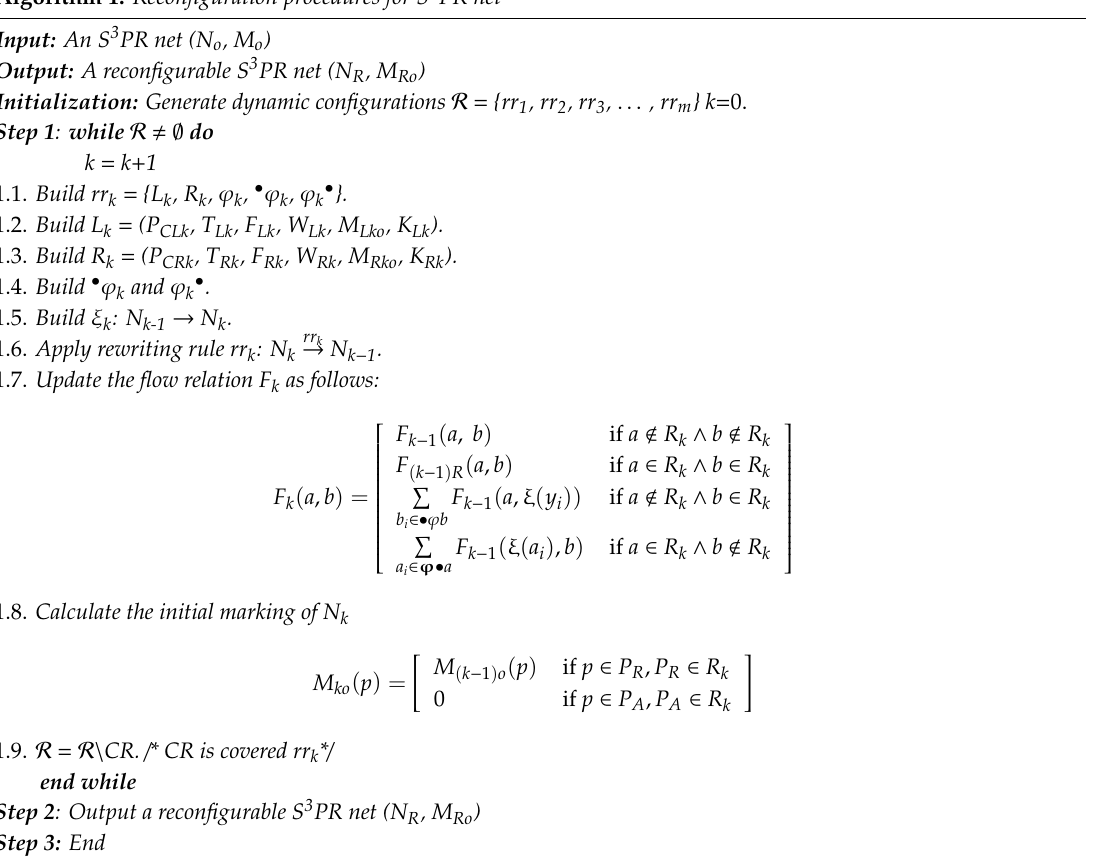
Algorithm 1: Reconfiguration procedures for S 3 PR